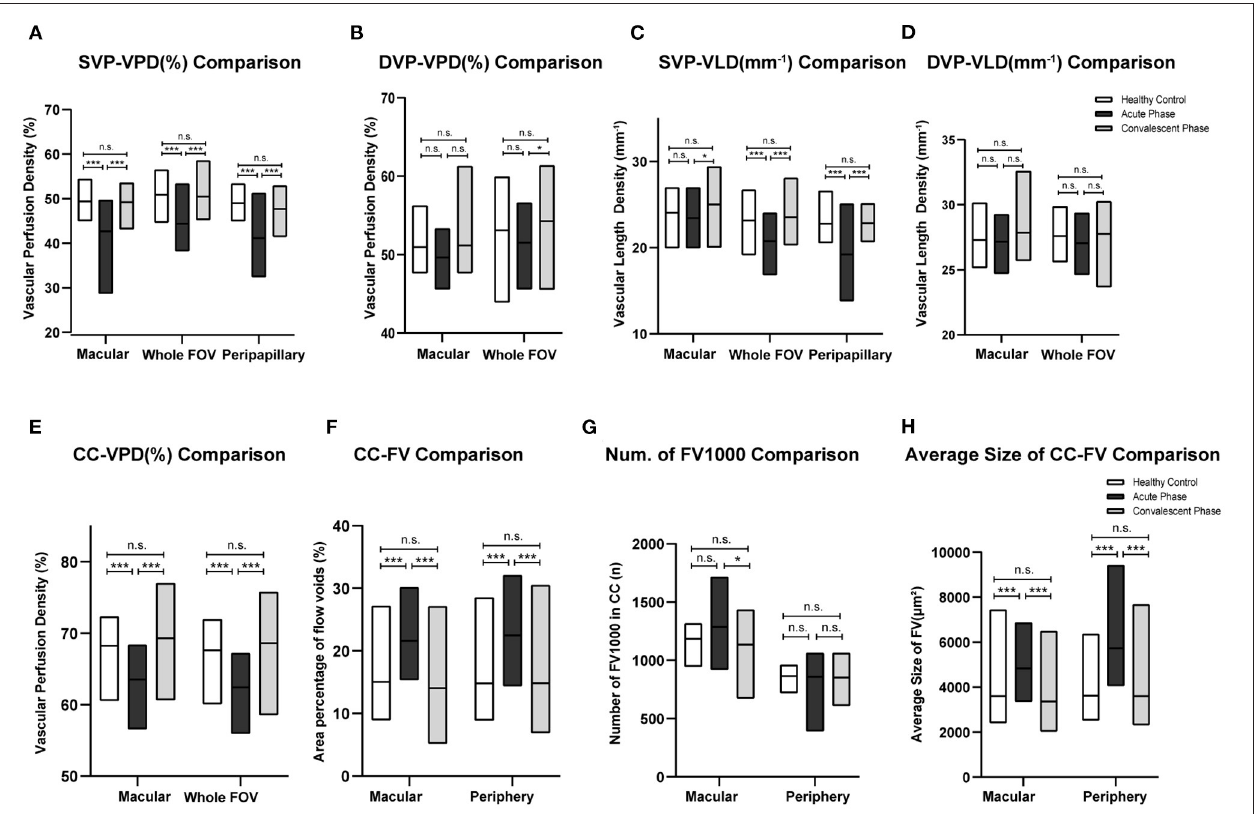
FIGURE 3 | Comparisons of different parameters among three groups in accordance to Tables 2 – 4 . Bar-graphs represent mean (range) (A–F) or median (range) (G,H) . (* p < 0.05; *** p < 0.001; n.s., non-significant).